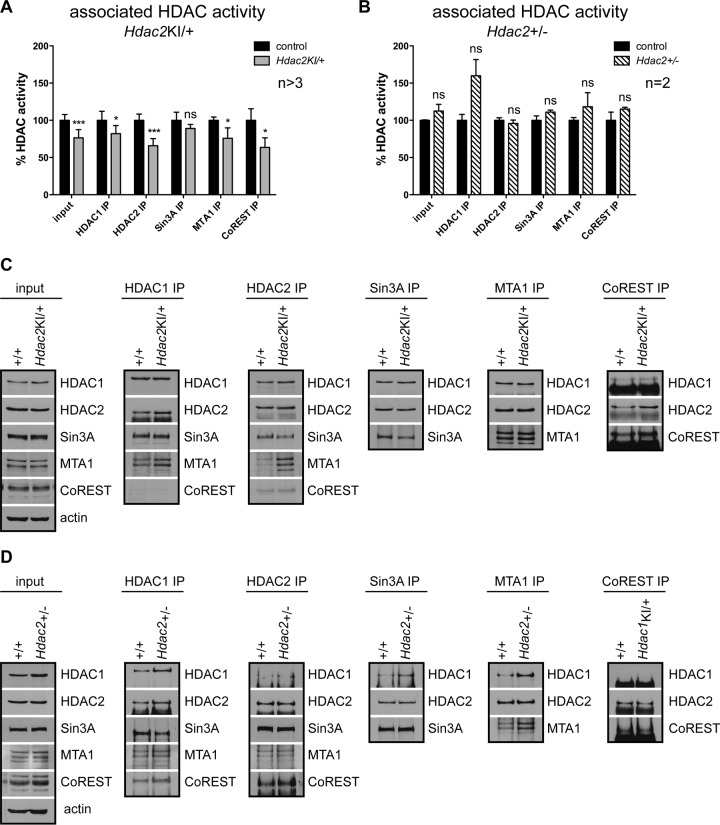
Dominant negative effect of catalytically inactive HDAC2-H142A. Shown are data from coimmunoprecipitation experiments with P0 brain protein extracts from Hdac2KI/+ (A and C) and Hdac2+/− (B and D) mice and the corresponding wild-type littermate controls using antibodies against HDAC1, HDAC2, Sin3A, MTA1, and CoREST. (A and B) Total deacetylase activity was analyzed in inputs and immunoprecipitates (IP). Error bars indicate SD (n > 3 [A] and n = 2 [B]). *, P < 0.05; ***, P < 0.001; ns, not significant. (C and D) The same input extracts and immunoprecipitates from Hdac2KI/+ (C) and Hdac2+/− (D) mice with the corresponding wild-type littermate controls were analyzed in immunoblots with antibodies against HDAC1, HDAC2, CoREST, Sin3A, MTA1, and β-actin, which was used as a loading control.